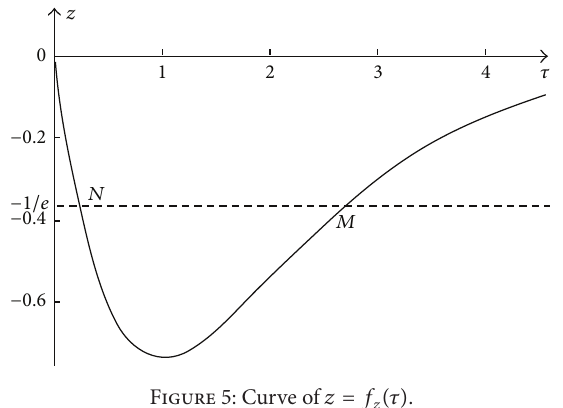
Figure 5: Curve of 𝑧 = 𝑓 𝑧 (𝜏)